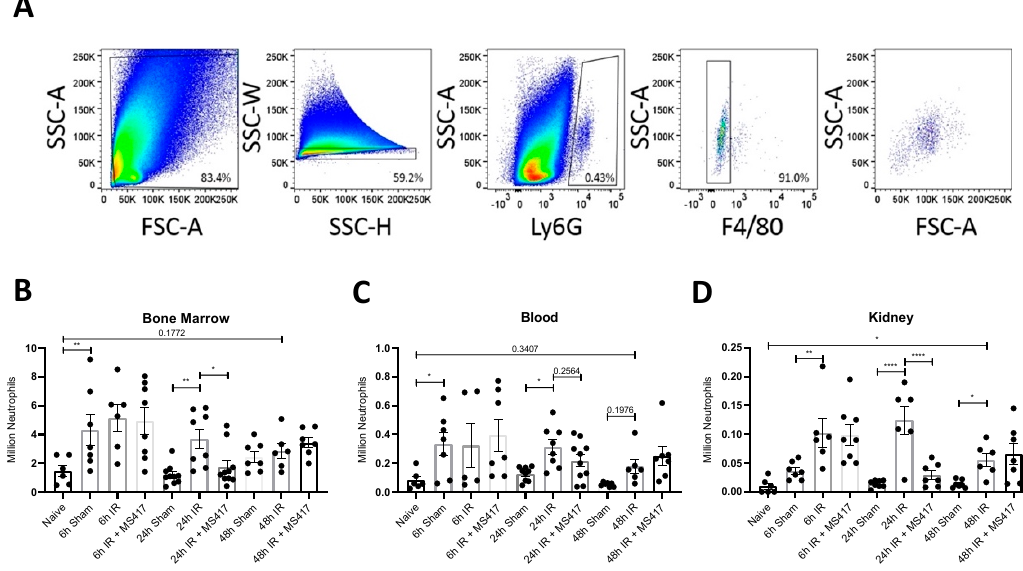
Figure 7. BRD4 inhibition attenuated absolute neutrophil counts in the bone marrow, circulation and kidney tissue following IRI ( A ) Flow cytometry gating strategy in kidney tissue. Mouse PMNs were gated based on Ly6G +ve /F4/80 − ve . Doublets were excluded using SSC-W x SSC-H. ( B – D ) C57BL6 mice were treated with 1 µ M MS417 daily for 7 days by oral gavage before unilateral IRI. Bone marrow ( B ), blood ( C ) and kidney tissue ( D ) was collected at 6, 24, and 48 h following IRI and absolute neutrophil counts were quantified by flow cytometry. ANOVA with Fischers LSD test was performed. n = 7–11, * p < 0.05, ** p < 0.01, **** p < 0.0001.